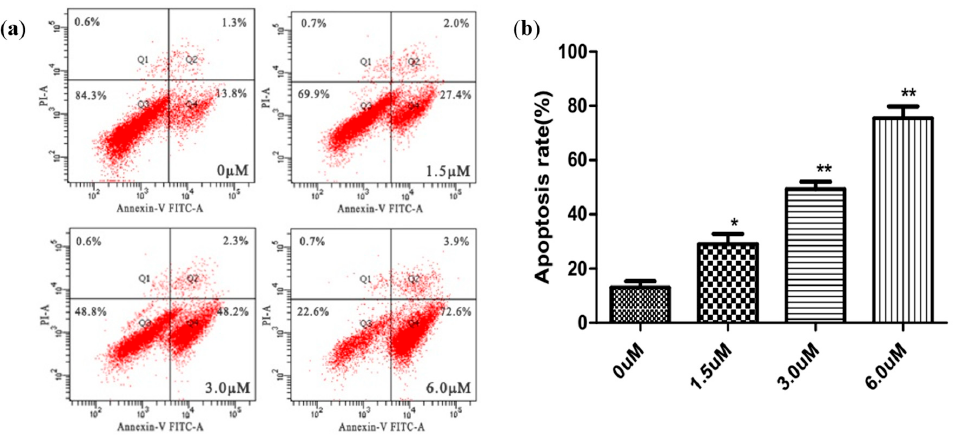
Figure 3. Analysis of HSCs apoptosis using annexinV-FITC/PI staining. Values are expressed as